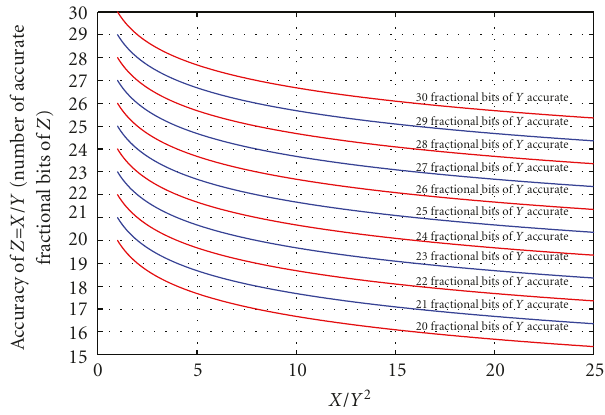
Figure 14: Accuracy of division Z = X/Y depends on accuracy of the operand Y and ratio X/Y 2 (assuming that Y value is much larger than inaccuracy of X ).